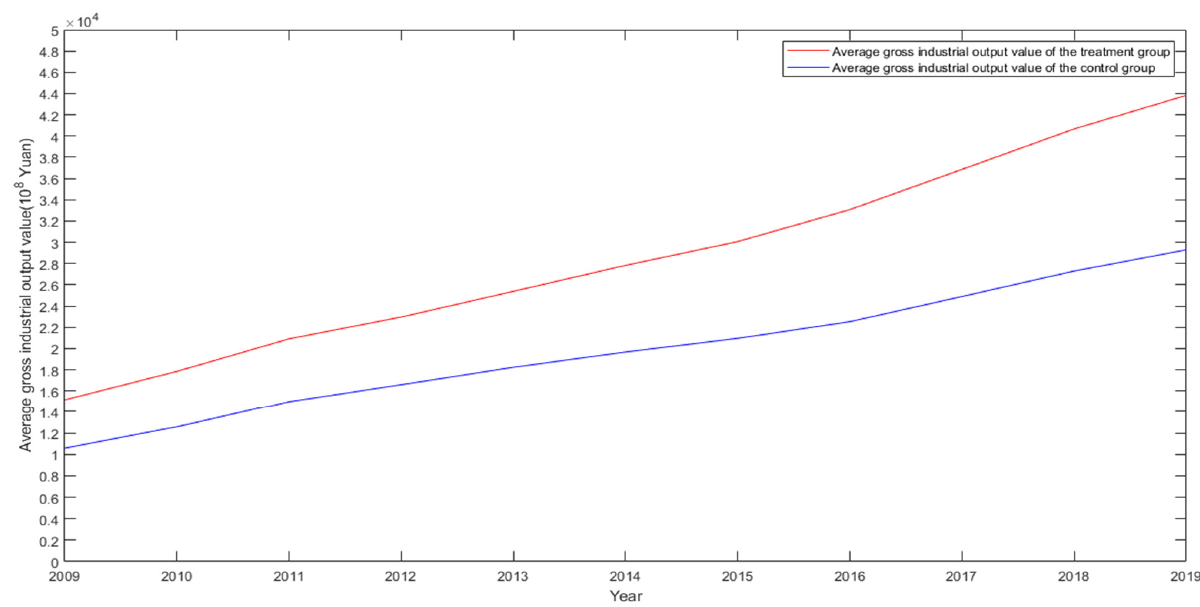
2 emissions from 2009 to 2019.